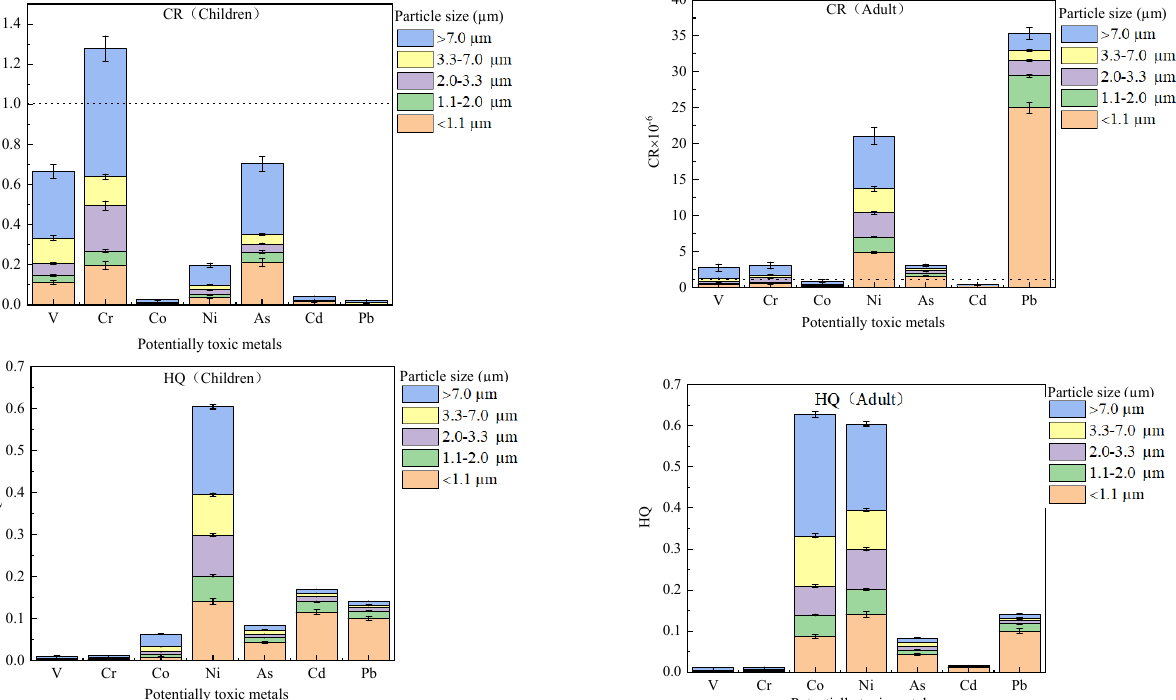
Figure 9. The carcinogenic and non- carcinogenic risks of toxic elements within PM 1.1 , PM 1.1–2.0 , PM 2.0–3.3 , PM 3.3–7.0 , PM >7.0 in Beijing during the sampling period.